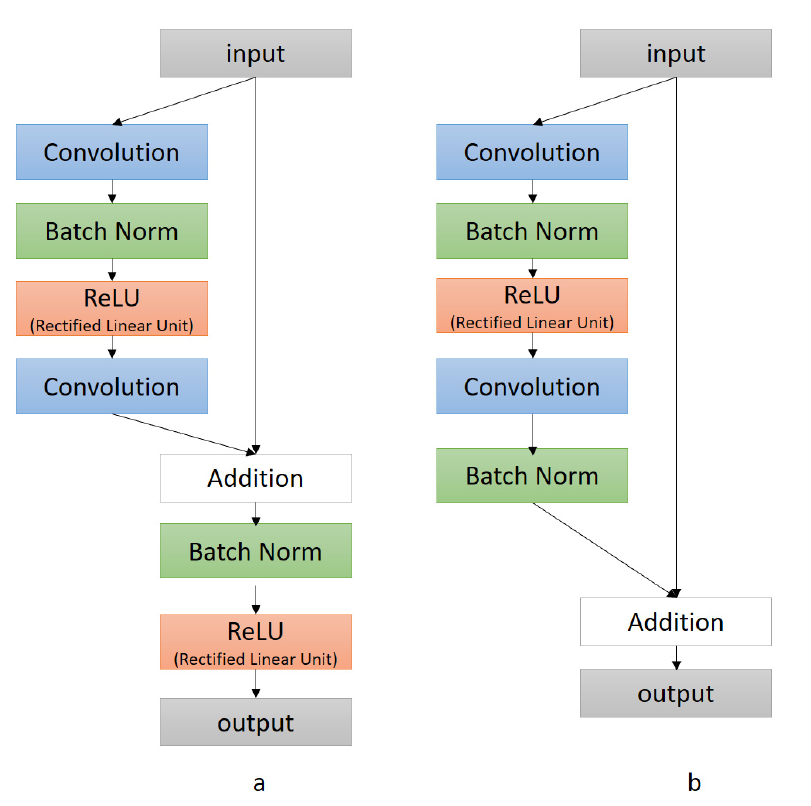
Figure 2. Different residual block frameworks in ResNet ( a ): Multiple batch norm calculations are used. ( b ): only one batch norm calculation is performed in the residual block.